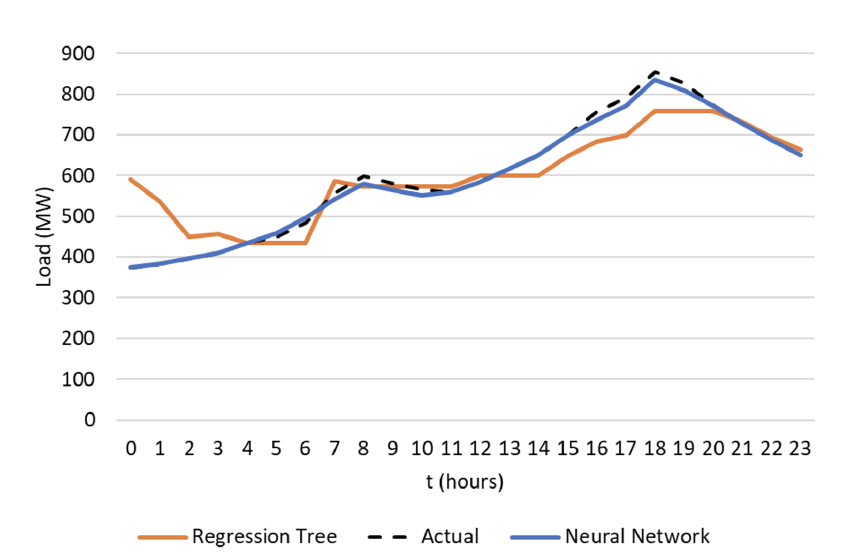
Figure 11. Implications of different optimizers on the feed-forward neural network performance.